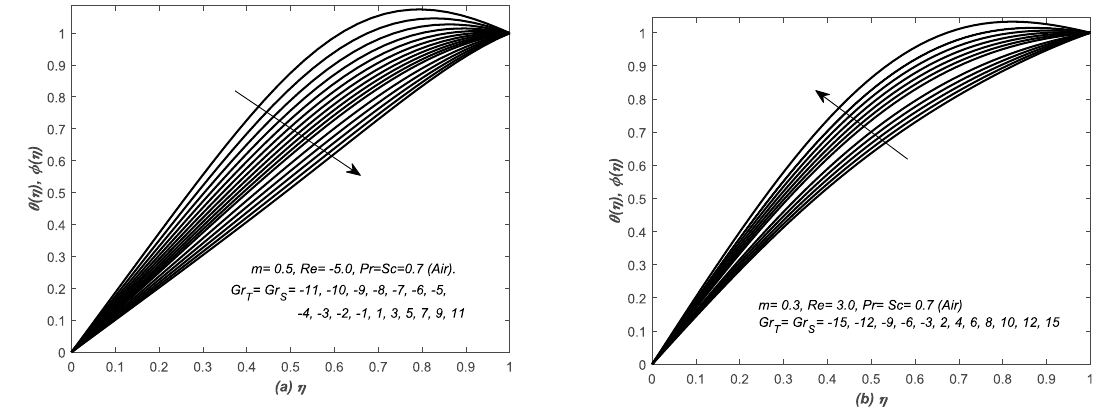
Figure 9. The dimensionless temperature θ(η) and species concentration φ(η) are plotted against the similarity variable η for assisting and opposing flow of air inside ( a ) converging and ( b ) diverging channels.